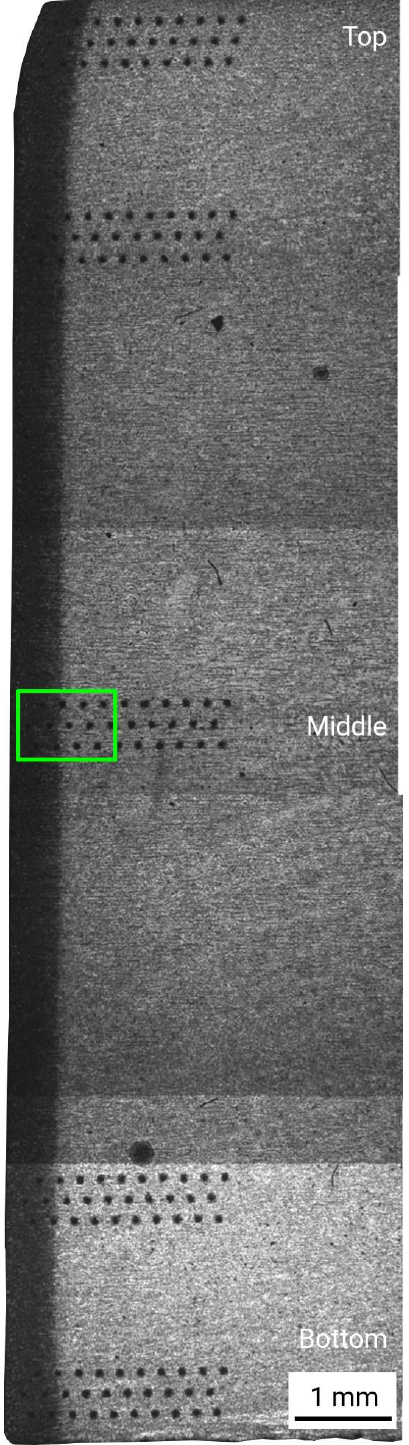
Figure 4. Optical micrograph of the CHAZ, ethed with 2% Nital. The Vickers indentations made for measuring hardness profiles are visible. The upper-left part corresponds to the plasma inlet (see also Figure 1a). Figure